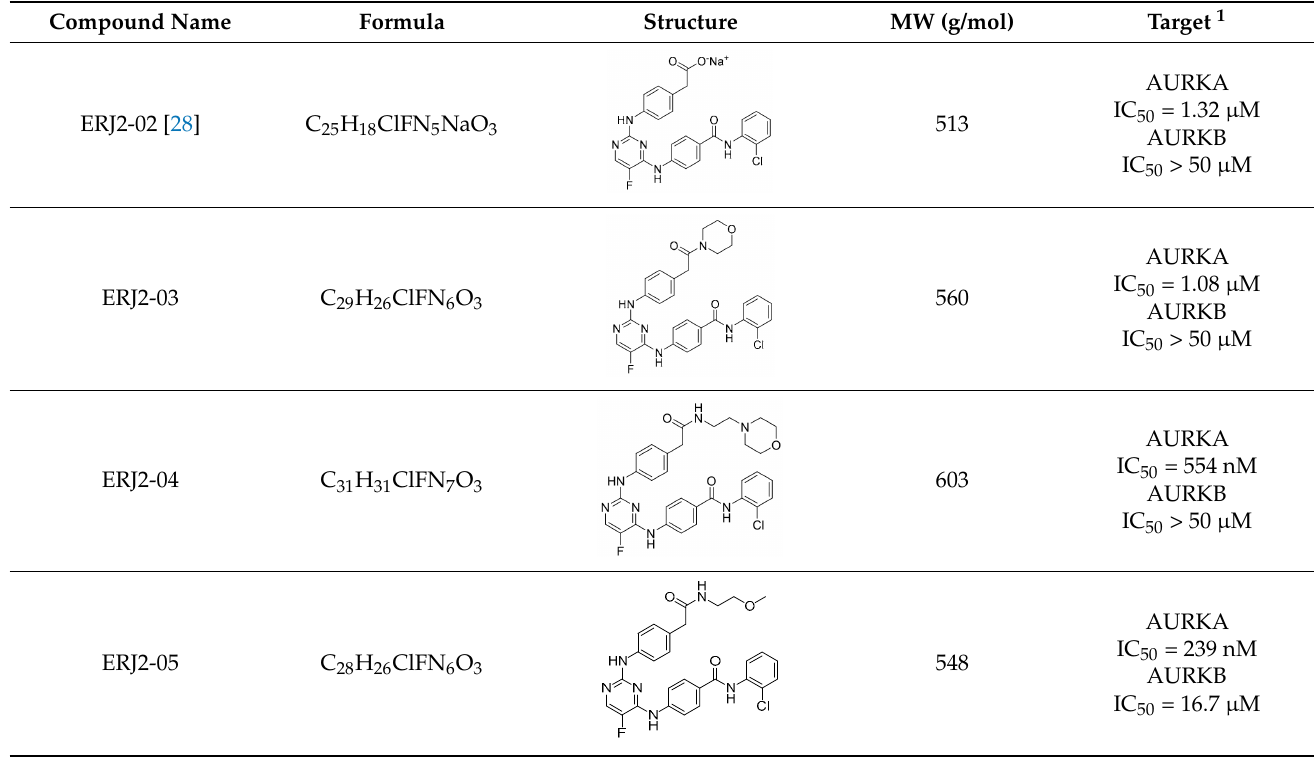
Table 2. Novel Aurora-A inhibitor I derivatives.